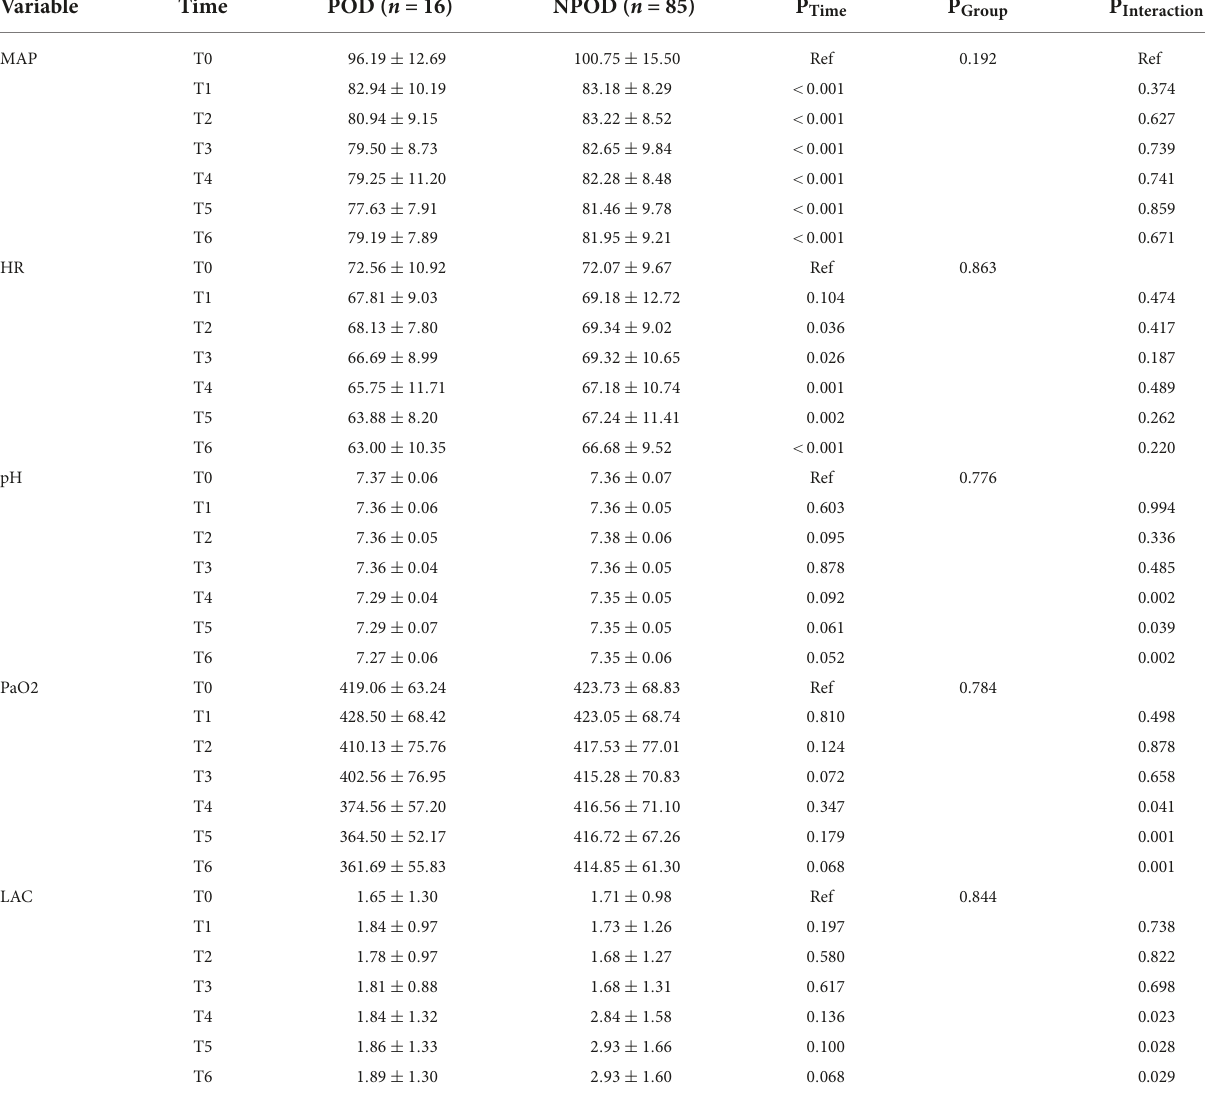
TABLE 3 Comparison of the characteristics between the postoperative delirium (POD) and non-POD groups at multiple time points. Variable